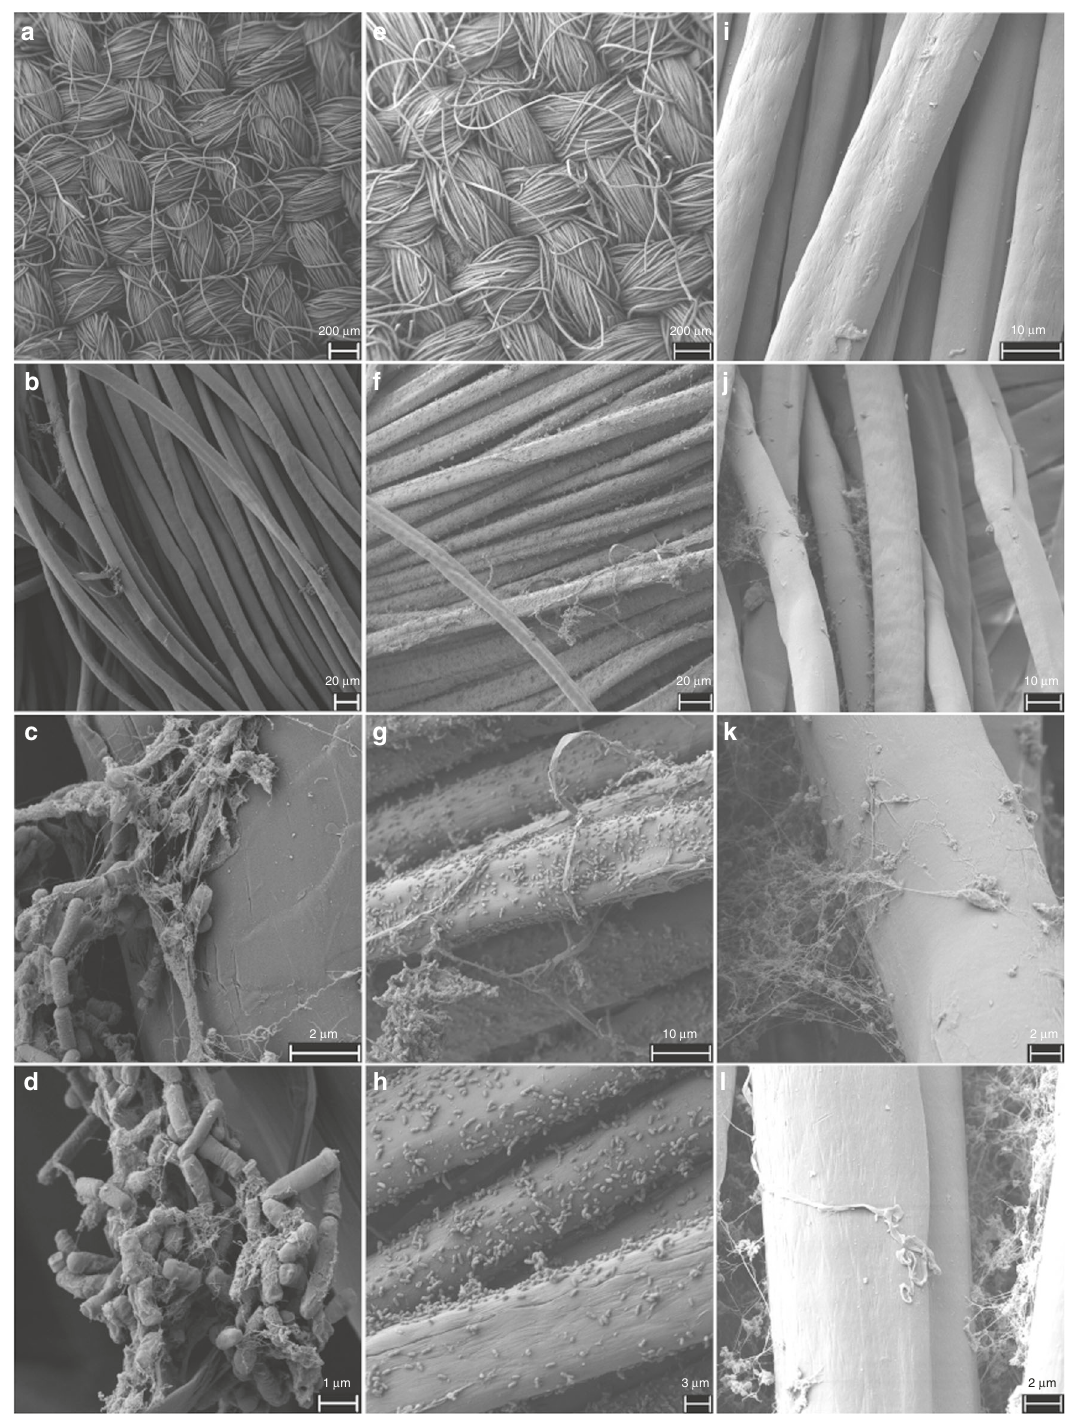
Fig. 7 Scanning electron micrographs of NOMEX ® fabric. The fabric was co-incubated for 6 weeks with bacteria isolated from the ISS: a – d Co-incubation with Bacillus paralicheniformis ; e – h Co-incubation with Cupriavidus metallidurans ; i – l Negative control of NOMEX ® fabric kept in sterile medium for 6 weeks. Precipitates found in the negative control were found to be remnants of the medium/particles and did not contain microbial